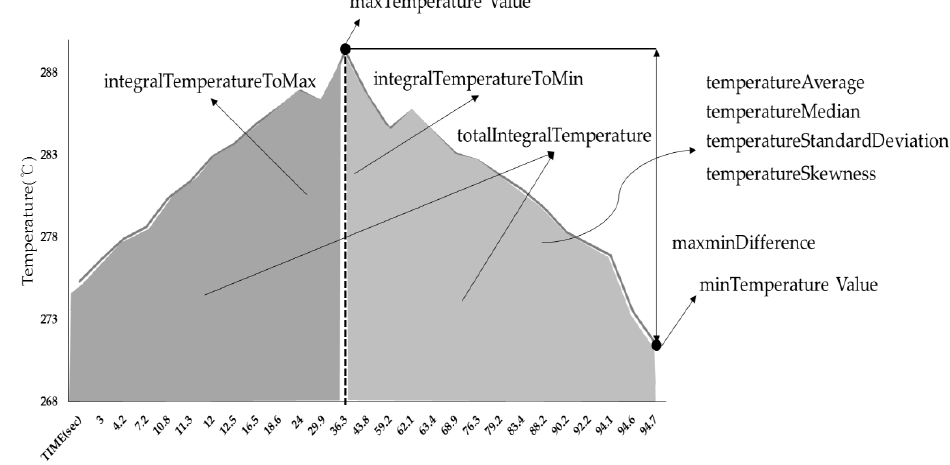
Figure 6. Extracting features from mold-temperature data.